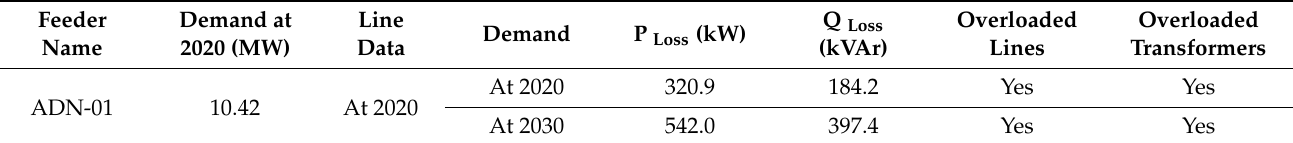
Table 3. Results of the existing network at peak demand in 2020 and 2030.